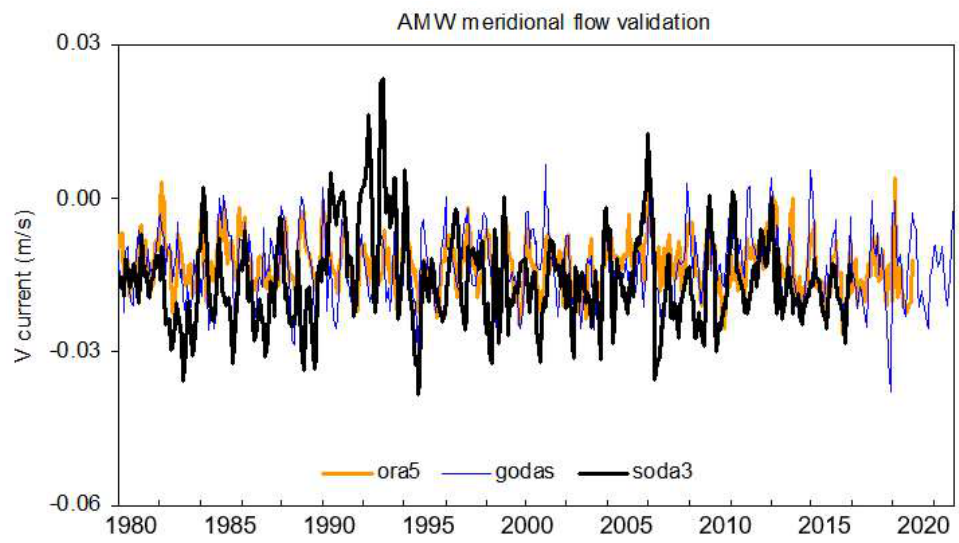
Figure A1. Passage flows (Sv) around the Caribbean adapted from [22].